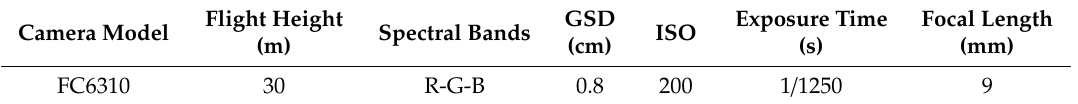
Table 2. Image acquisition details of the used datasets (GSD: Ground sampling distance; ISO: International Organization of Standardization).